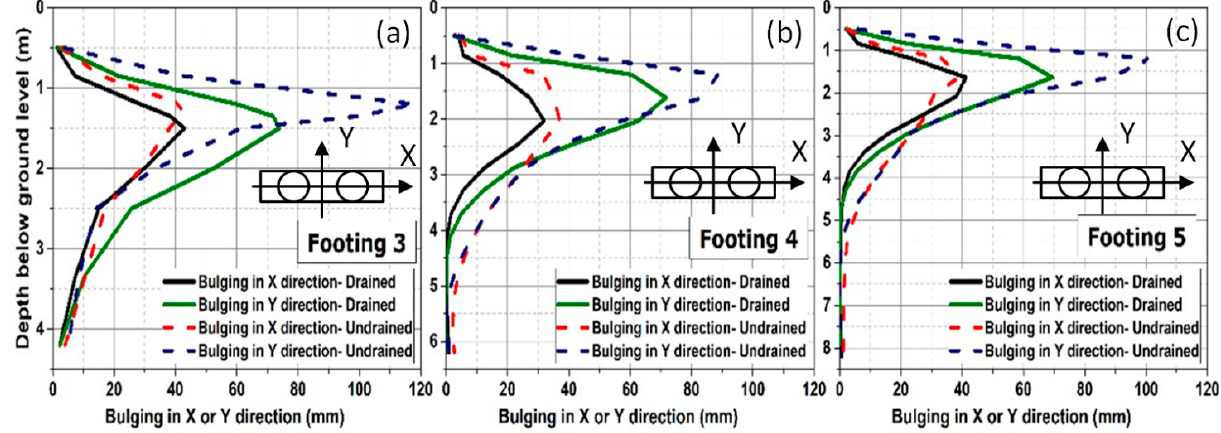
Figure 9. Column bulging of ( a ) Footing 3; ( b ) Footing 4; ( c ) Footing 5 at applied pressure of 190 kPa.